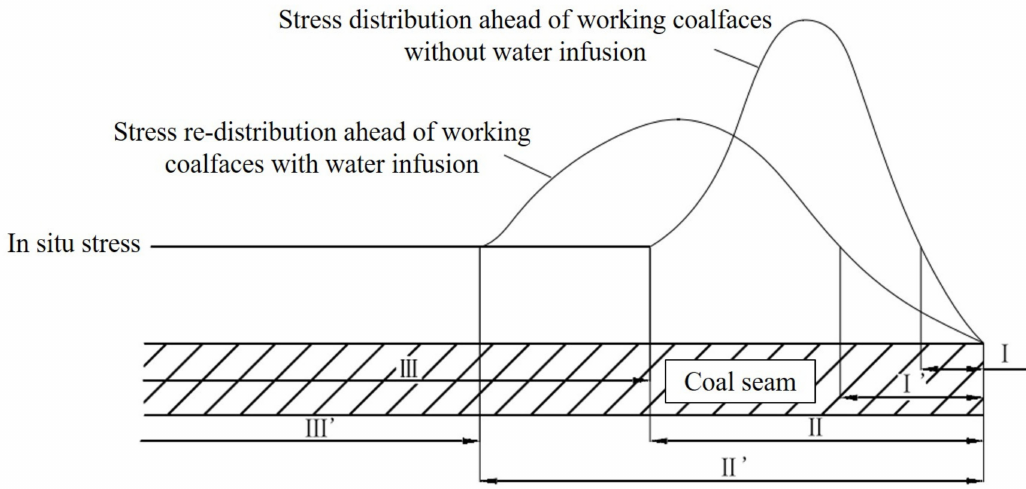
Figure 1. Stress distribution ahead of working coalfaces [2,15]. I—Stress relief zone before water infusion; II—stress concentration zone before water infusion; III—in situ stress zone before water infusion; I’—stress relief zone after water infusion; II’—stress concentration zone after water infusion; III’—in situ stress zone after water